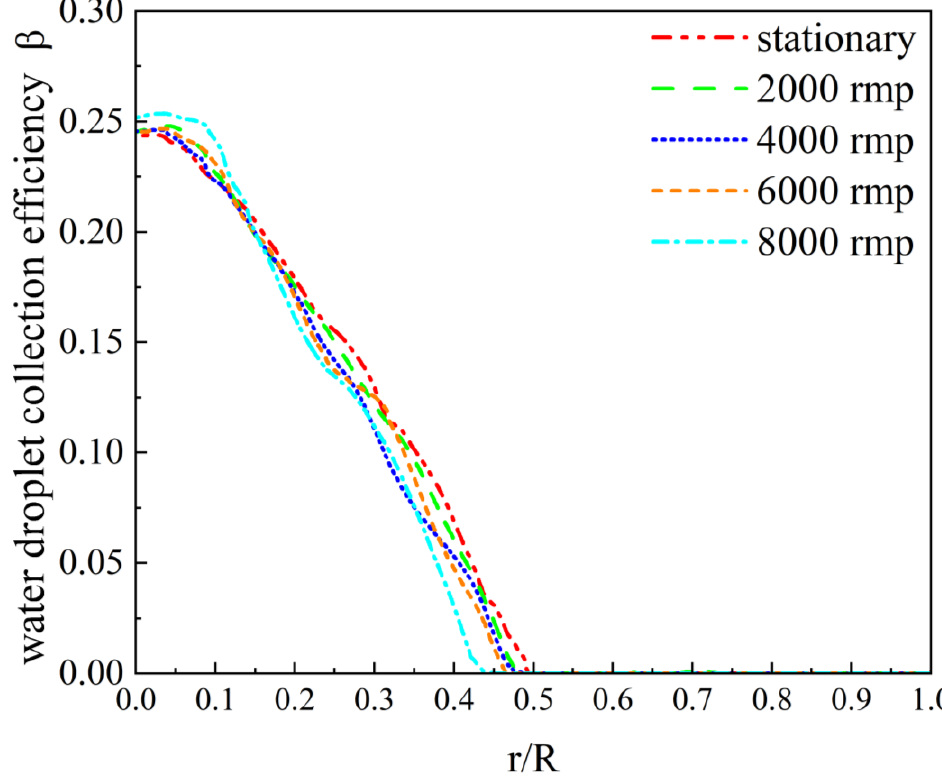
Figure 11. Water droplet collection efficiency 𝛽 with different rotational speeds on the elliptical